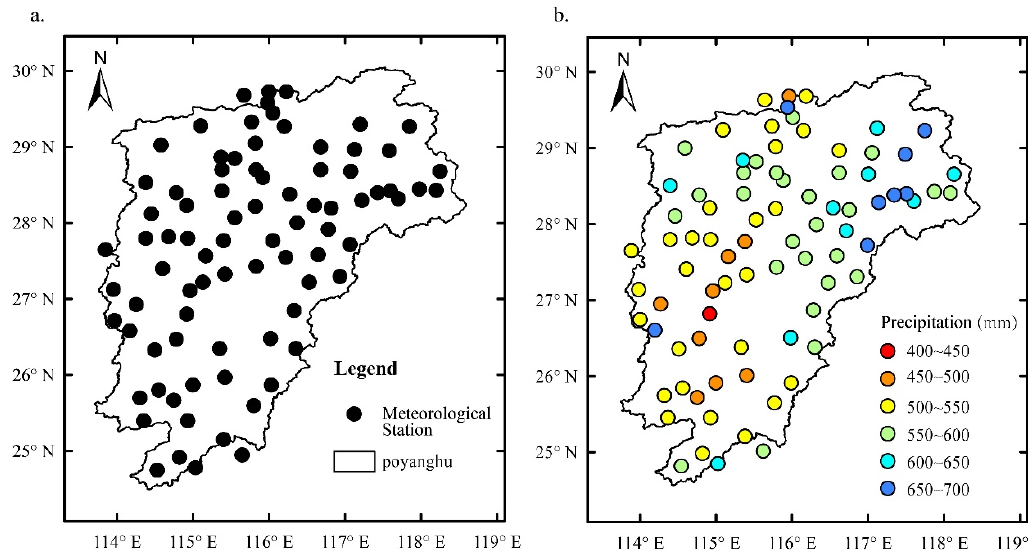
Figure 2. Distribution of the meteorological stations in the Poyang Lake basin. ( a ) the Chinese Meteorological Agency (CMA) for a total of 87 meteorological stations; ( b ) the summer totals precipitation climatology employed over the 1961–2016 study period.